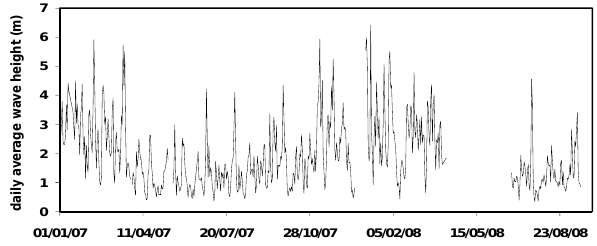
Fig. 5. Daily average wave height at Anasuria (57 ◦ 15 0 38N, 000 ◦ 48 0 48E).